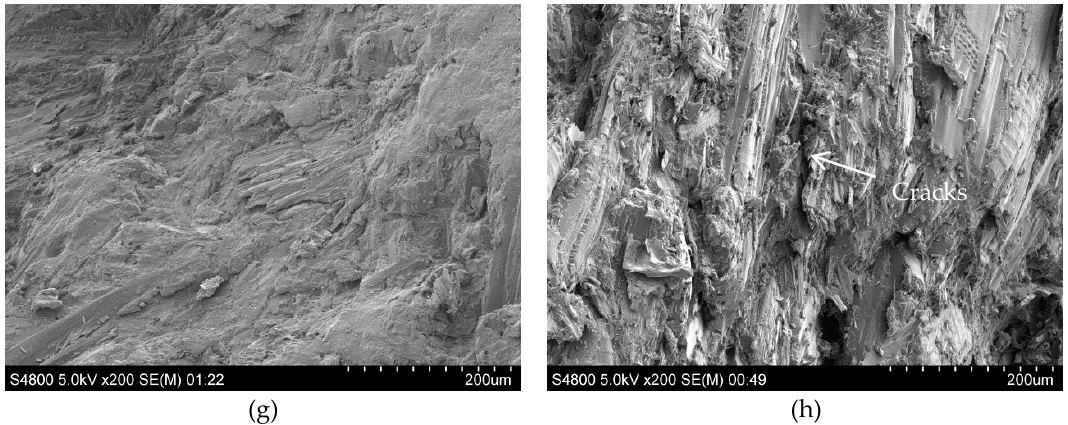
Figure 4. SEM micrographs of virgin and OMMT-modified PLA and the composites. ( a ) PLA; ( b ) 0.5/PLA; ( c ) 1.5/PLA; ( d ) 2/PLA; ( e ) PLA/WF; ( f ) 0.5/PLA/WF; ( g ) 1.5/PLA/WF; ( h ) 2/PLA/WF.